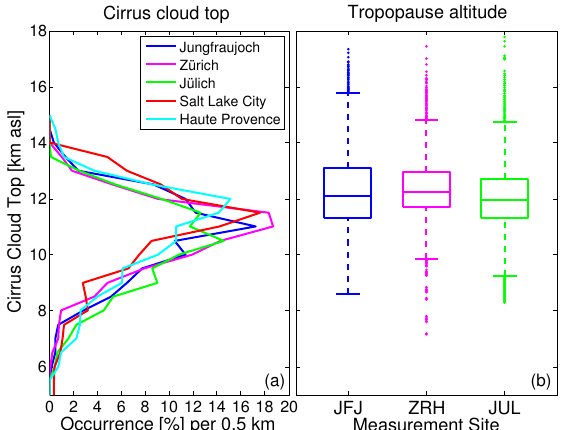
Figure 7. (a) Cloud tops (in 500m steps) at the three sites of this study as well as in Salt Lake City by Sassen and Campbell (2001) and Haute Provence by Hoareau et al. (2013). (b) Tropopause derived from COSMO regional weather forecast model analyses (2.2km horizontal resolution for JFJ and ZRH, 6.6km resolution for